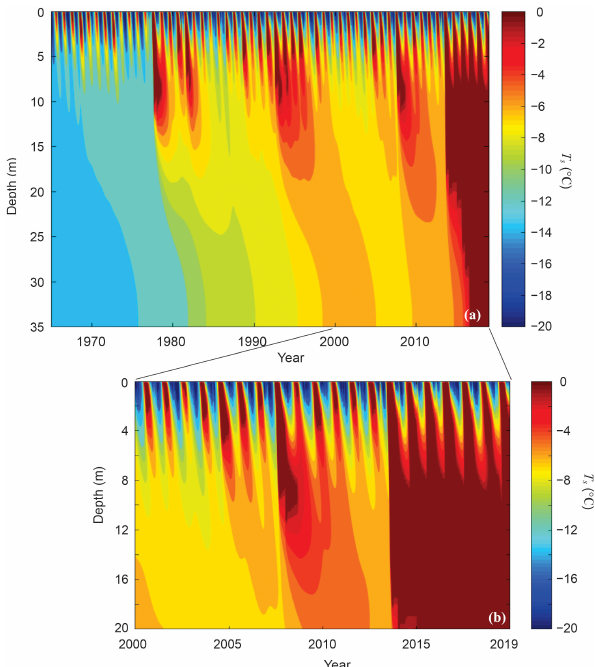
Figure 6. Modelled subsurface temperature evolution for the refer- ence model climatology and parameter settings: (a) 1965–2019, full 35m firn column; (b) 2000–2019, upper 20m. Deep temperate con- ditions conducive to a firn aquifer developed from 2013 to 2017, in response to several subsequent summers of high melting and deep meltwater